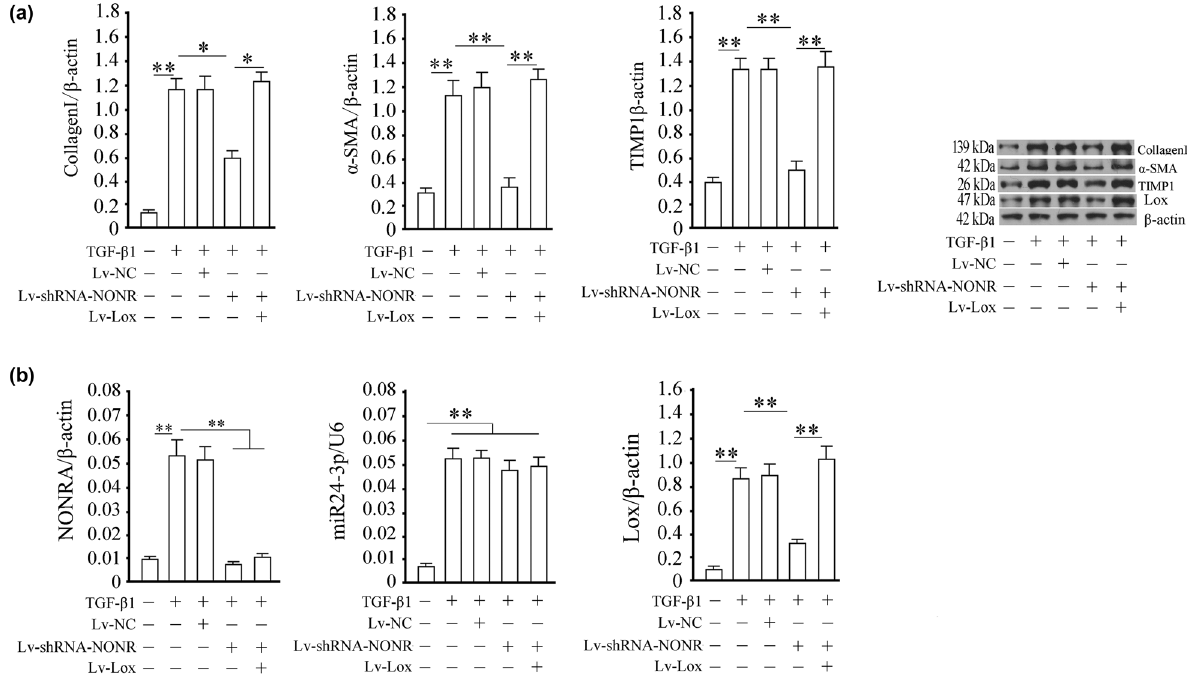
Figure 5: Silencing NONRATT013819.2 inhibited biological functions in TGF - β 1 - activated HSCs by miR24 - 3p/Lox. ( a ) The expression of activated characteristic proteins of collagen I, α - SMA, and TIMP1 was detected by western blotting. ( b ) The relative concentrations of NONRATT013819.2 and miR24 - 3p and Lox protein expression in each group of HSCs. The quantitative detection of NONRATT013819.2 and Lox was normalized by β - actin, and miR24 - 3p was normalized by U6. The results were expressed as the mean ± SD from three independent experiments, * P < 0.05, ** P <